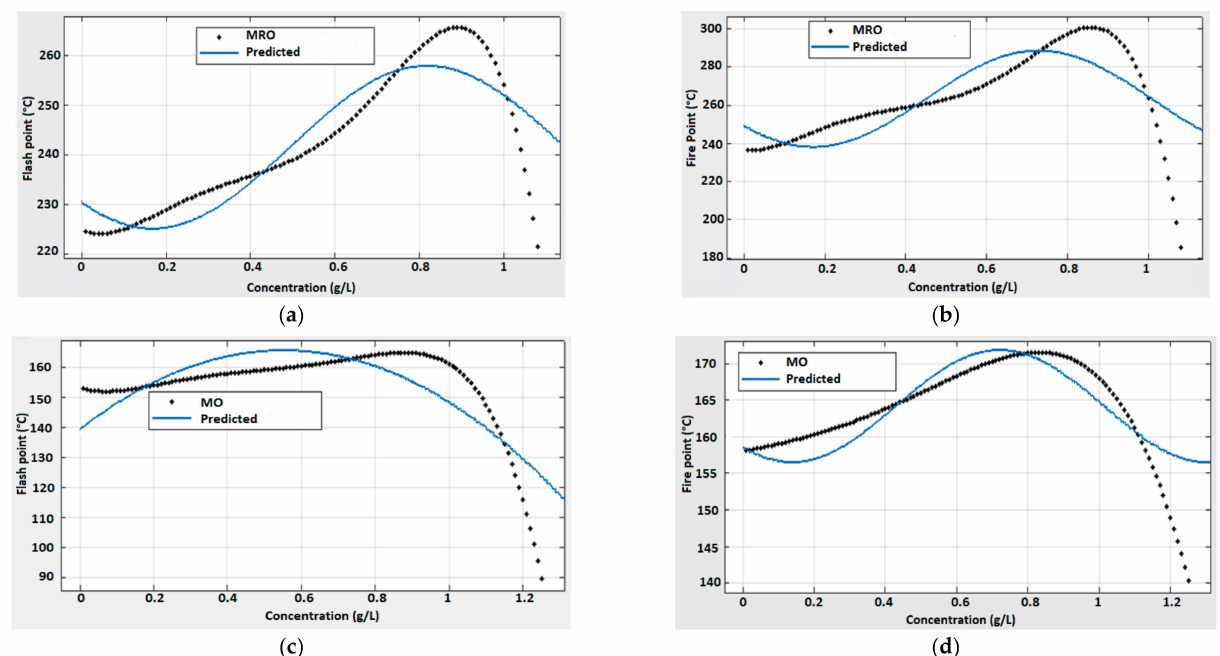
Figure 23. Comparison of measured and predicted flash point and fire point of MRO and MO using Lagrange polynomial interpolation function and Fourier distribution function. The predicted value showing deviation of ± 3 ◦ C and ± 0.2 g from the measured value, ( a ) flash point of MRO, ( b ) fire point of MRO, ( c ) flash point of MO, ( d ) fire point of